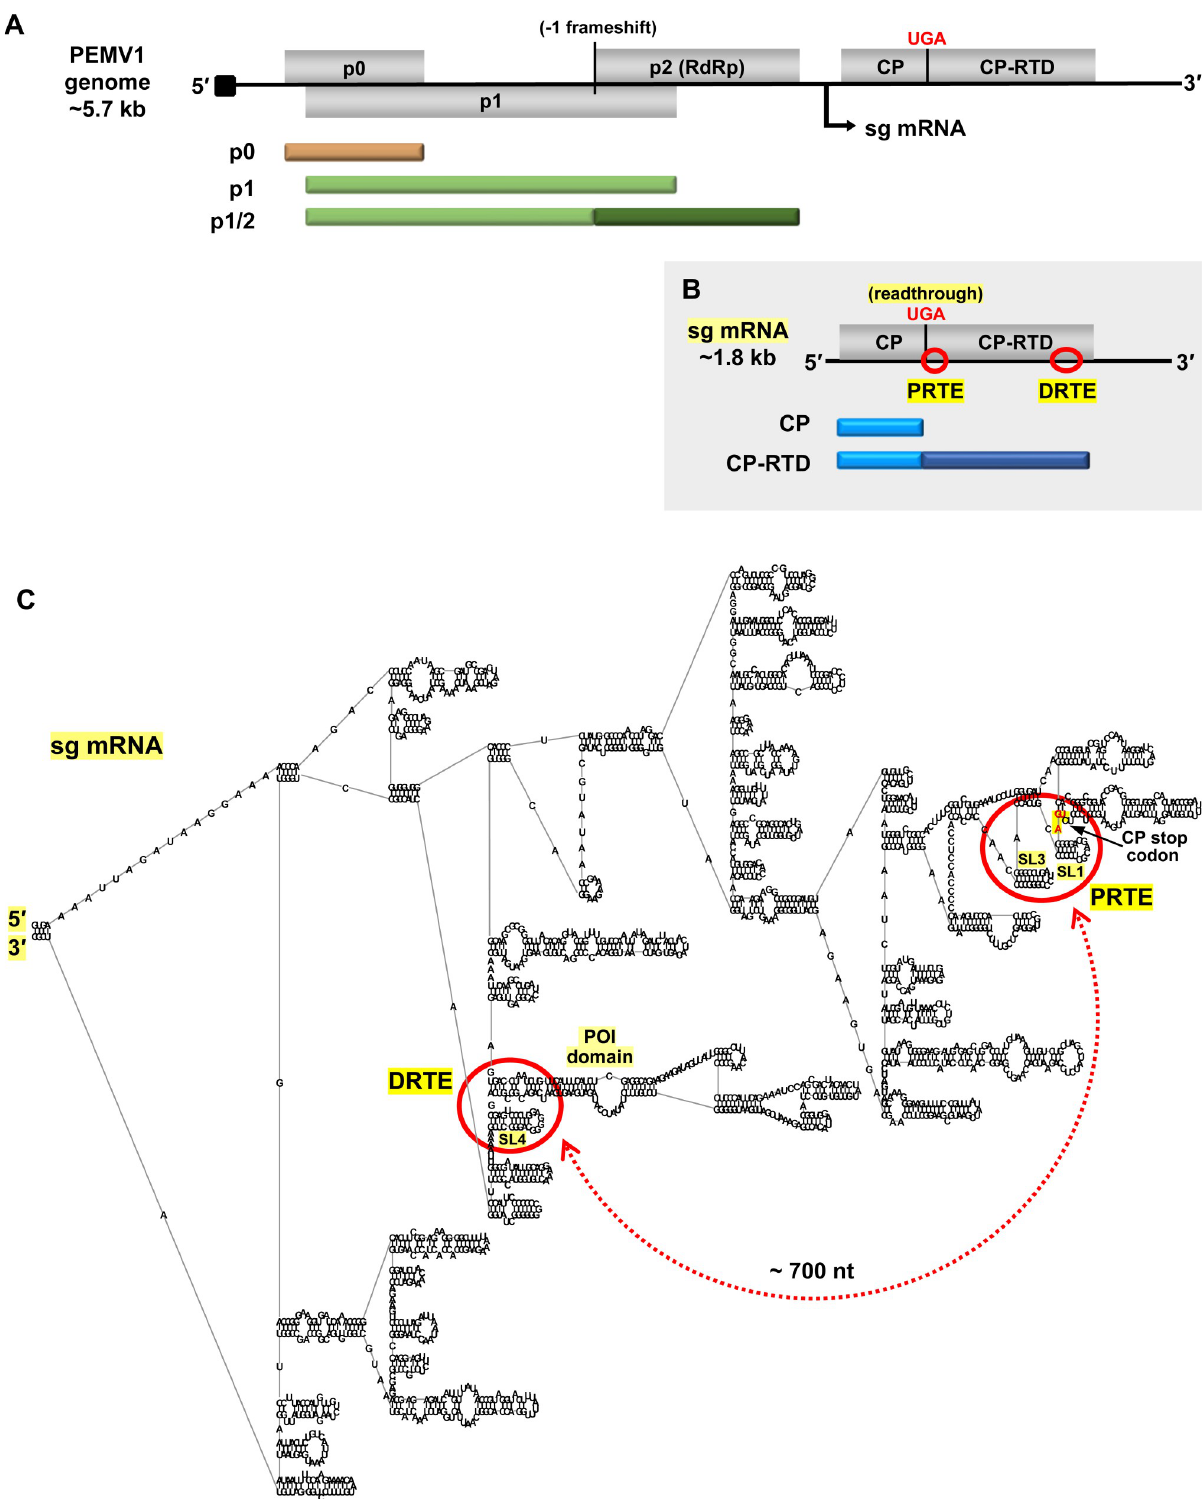
Fig 1. Organization of PEMV1 genome and subgenomic mRNA. (A) Linear representation of PEMV1 genome showing encoded ORFs (grey boxes) for p0, p1, p2, coat protein (CP) and coat protein-readthrough domain (CP-RTD). Proteins translated from the genome are shown beneath it as tan and green bars. P1/2 RdRp protein is expressed via programmed -1 frameshifting within the p1 ORF. Black arrow beneath the genome indicates the